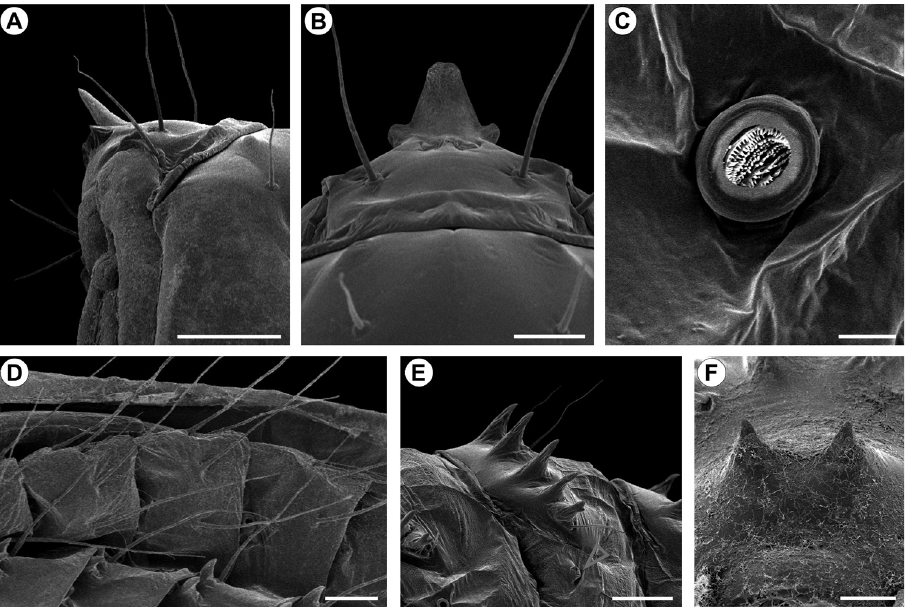
Figure 8. Cecidonius pampeanus pupal morphology with scanning electron microscopy. A, B head and prothorax, lateral and dorsal views, respectively C spiracle of sixth abdominal segment, dorsal D sub- spiracular setae from fourth to sixth abdominal segments, dorsal E tergal spines of eighth abdominal segment, lateral (arrow points to partially closed spiracle) F spines of tenth abdominal segment, posterior- dorsal. Scale bars: 0.5 mm( A ); 0.25 mm ( B, C, E ); 0.1 mm ( D, F